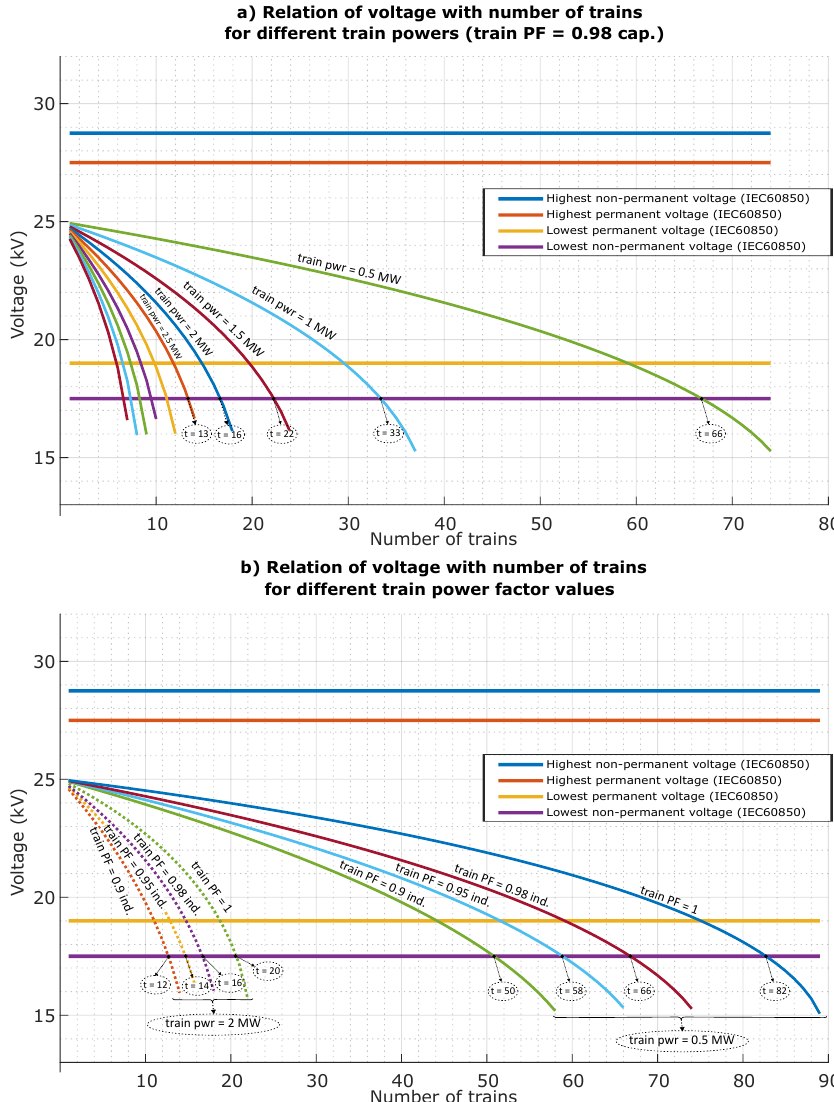
Figure 13. Relation of number of trains with voltage in neutral zone: ( a ) variation of active power in each train, for fixed PF = 0.98 ind.; ( b ) variation of power factor in each train, for fixed active power of 0.5 MW and 2